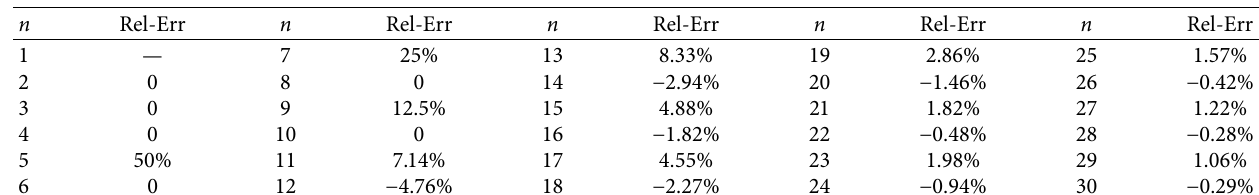
Table 9: The relative error of I